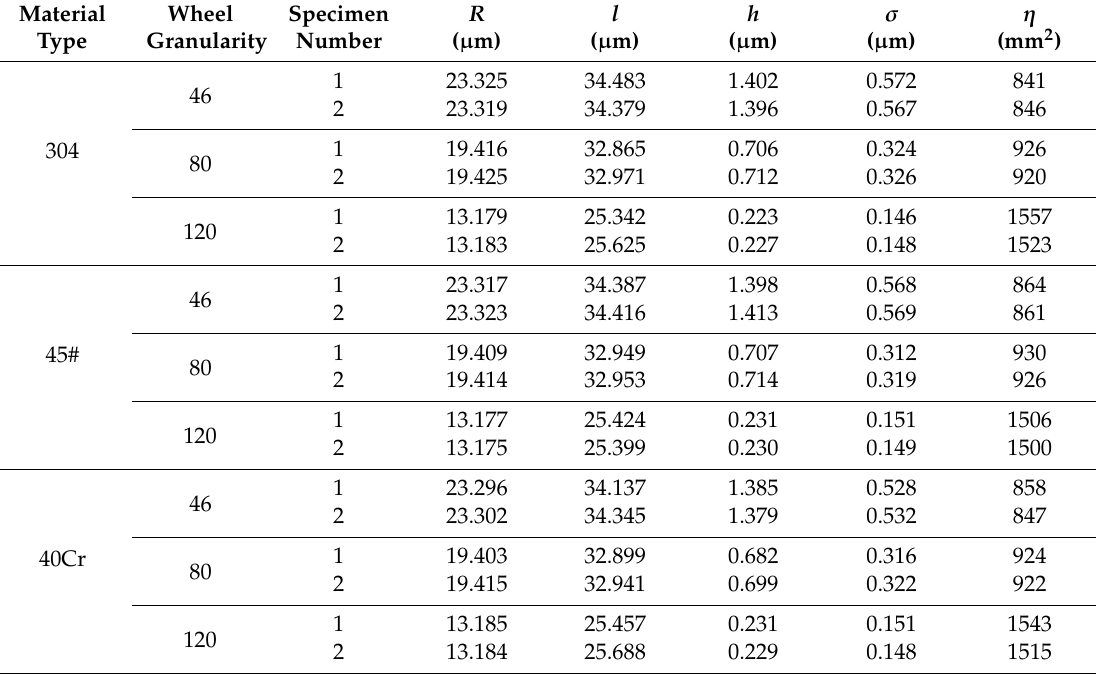
Table 2. Statistical parameters of the grinding surfaces for specimens.